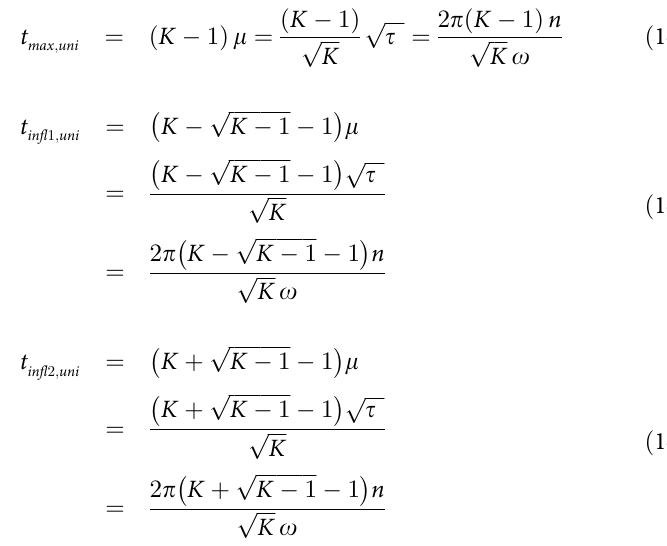
ffiffiffiffiffiffiffiffiffiffiffiffi